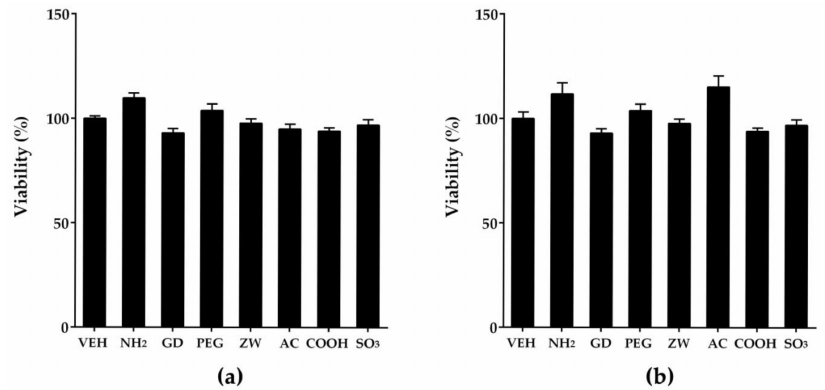
Figure 3. Cytotoxicity assay of nanoparticles to ( a ) THP-1 macrophages and ( b ) A549 cells. Cells were treated with nanoparticles at 50 µ g/mL for 4 h, and cytotoxicity was evaluated using the 3-(4,5-dimethylthiazol-2-yl)-5-(3-carboxymethoxyphenyl)-2-(4-sulfophenyl)-2H-tetrazolium (MTS) assay. Note that all types of nanoparticles showed no cytotoxicity at 50 µ g/mL.